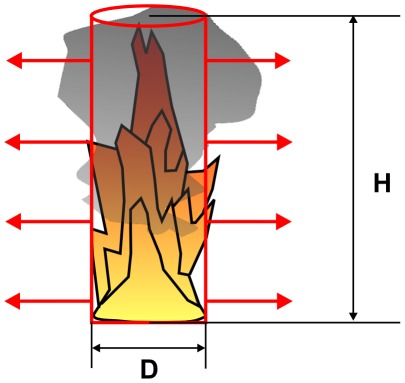
Solid flame model.